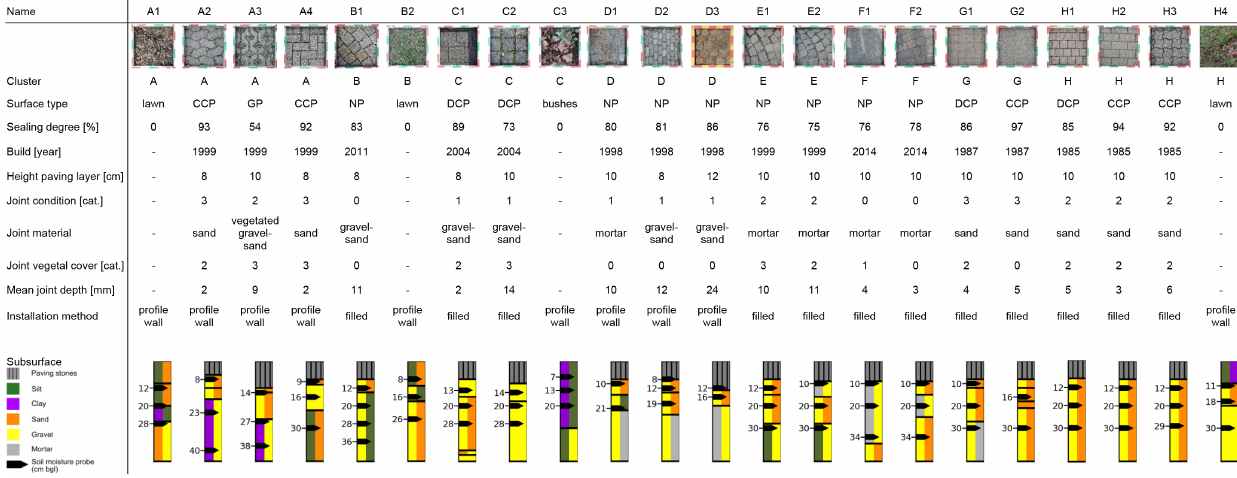
Table 1. Characteristics of the plots. Abbreviations of surface types follow the classification of Timm et al. (2018): CCP – classical concrete paving stones; DCP – designed concrete paving stones; GP – grass pavers; and NP – natural paving stones. The sealing degree equals 100% minus the joint proportion (%). Sensors were installed with two different methods. Either they were installed in the undisturbed profile wall (profile wall) or in the excavated hole, which was then filled from the top (filled). The profiles show the two soil components with the biggest share. Minor components are not visualized. All profiles are presented to a uniform depth of 45cm, although not all plots were excavated to this depth. In this case, the lowest layer encountered was extrapolated to a depth of 45cm for illustration purposes. In the case of the filled installation method, the depicted soil layers show the encountered soil material during excavation instead of the bedding material used for